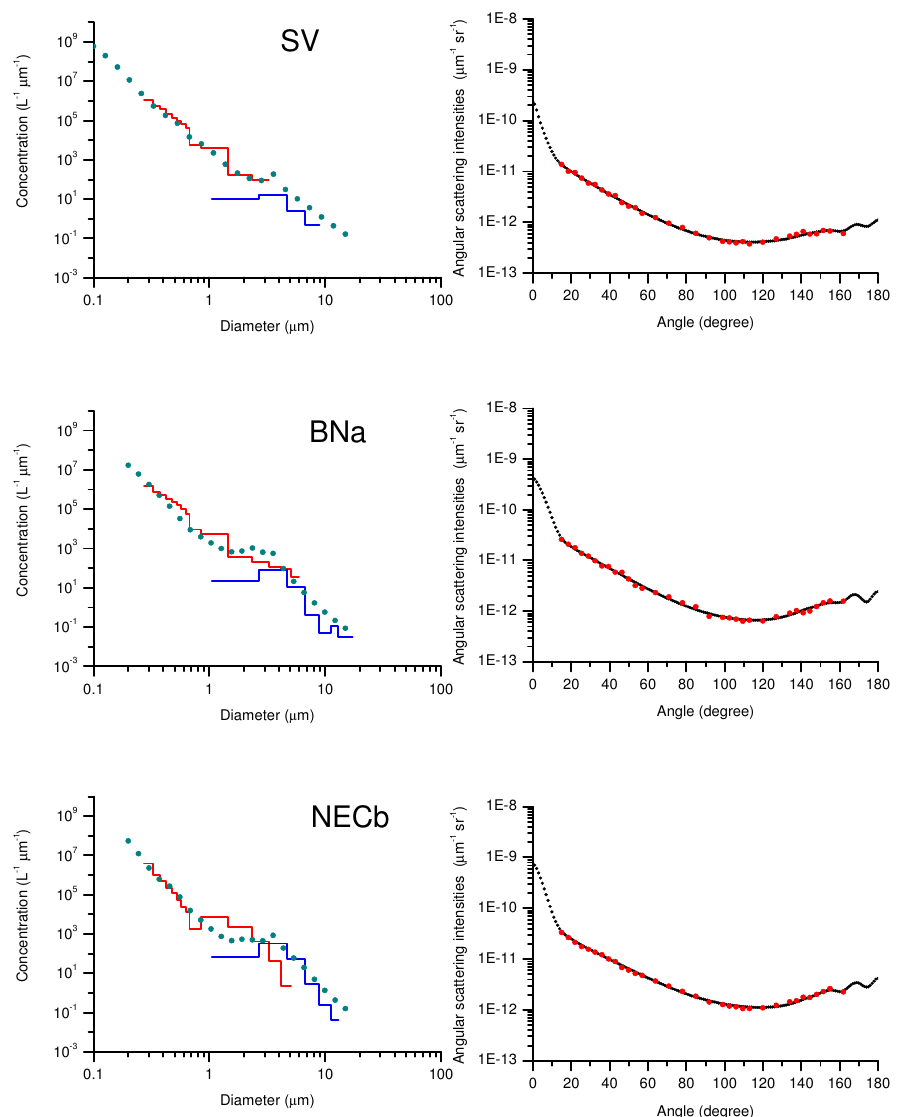
Figure 4. Measured (solid lines) and retrieved (solid black circles) aerosol size distributions (left panels). Measured (solid red circles) and reconstructed (solid black circles) angular-scattering intensities (right panels). Stromboli (top), Bocca Nuova (middle), and Northeast (bottom) Etna craters plums, respectively. (See notations in Fig.